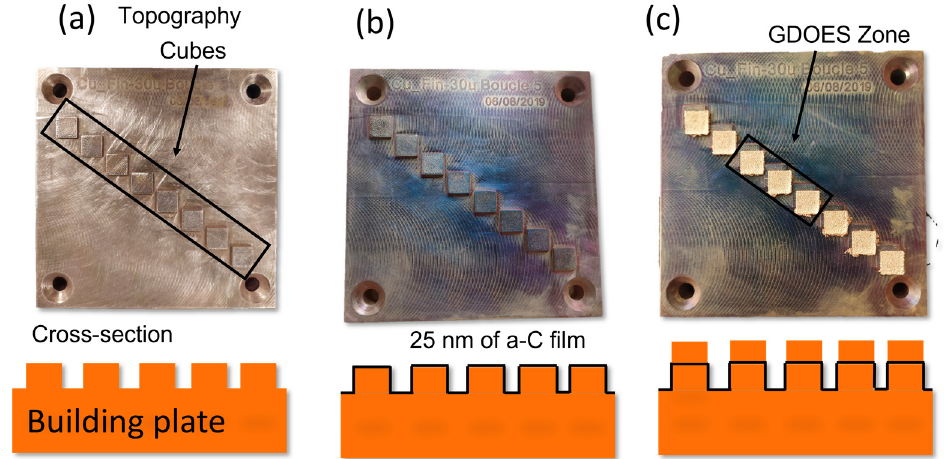
Figure 9. Topography and schematic cross-section representation of ( a ) The squares diagonal printed using SLM, ( b ) Deposition of 25 nm of a-C film by DMCS, and ( c ) Continuation of the printing process over the a-C film and region containing the three cubes analyzed by GDOES (black rectangle).